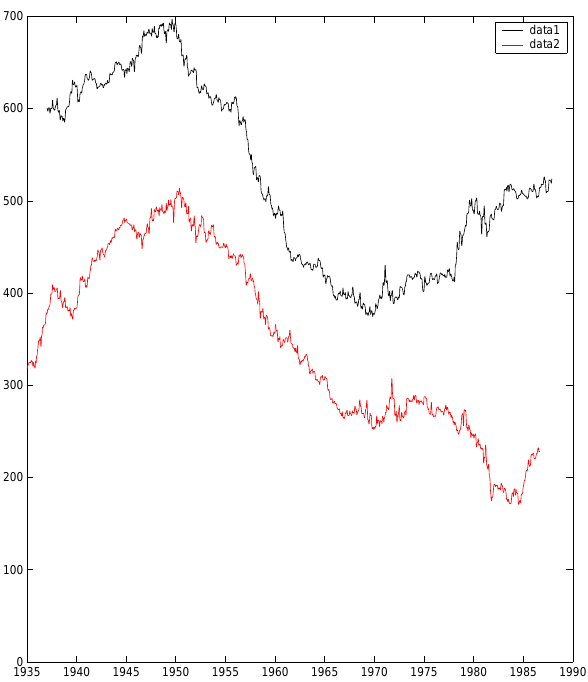
Fig. 11. Amplitude of the 12-month line (1) X component, HAD observatory (2) aa index. Vertical unit: .35 10 − 3 nT/day. Right vertical scale is for aa